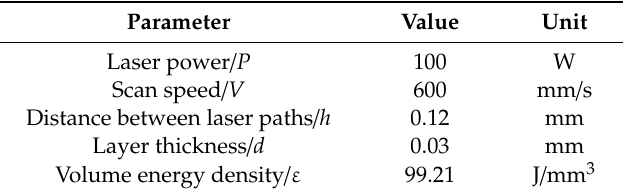
Table 1. Selective Laser Melting (SLM) process